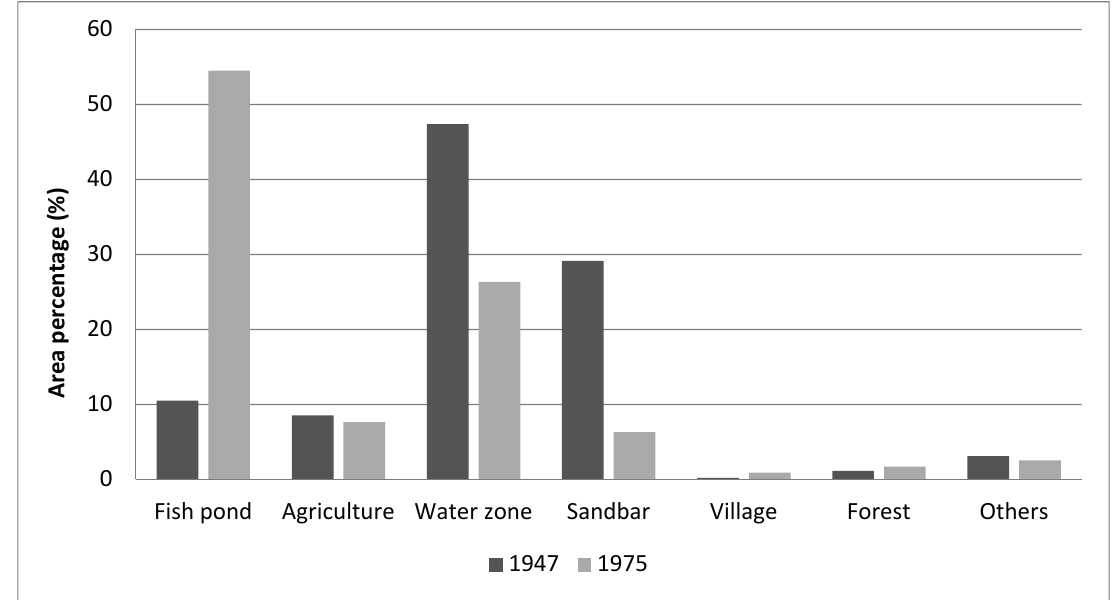
Figure 5. Histogram for area percentage of each land-use land-cover between 1947 and